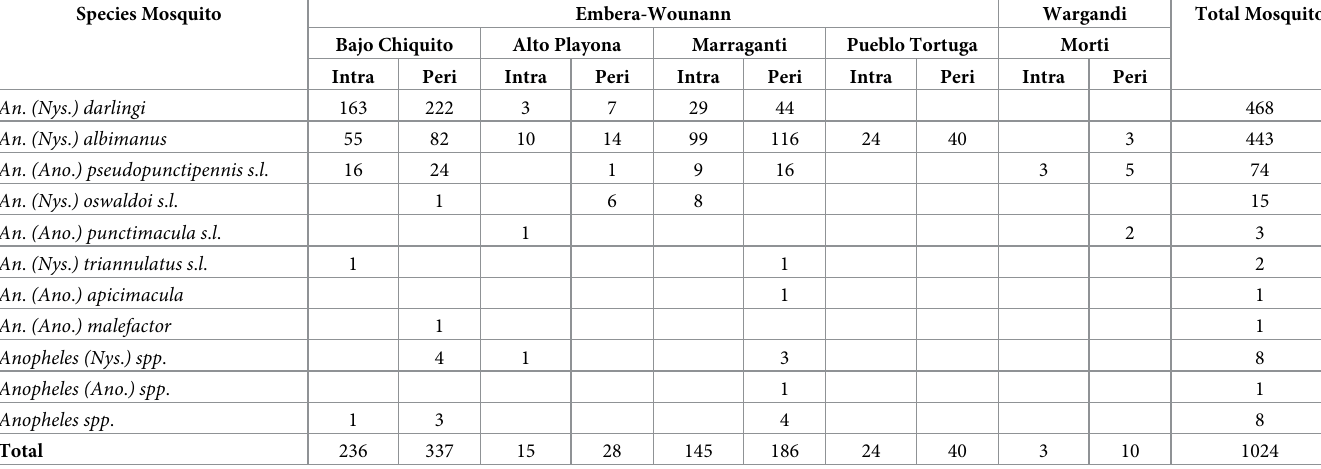
Table 3. Number of Anopheles species captured in the intradomicile and peridomicile in the communities sampled in the Darien Region,